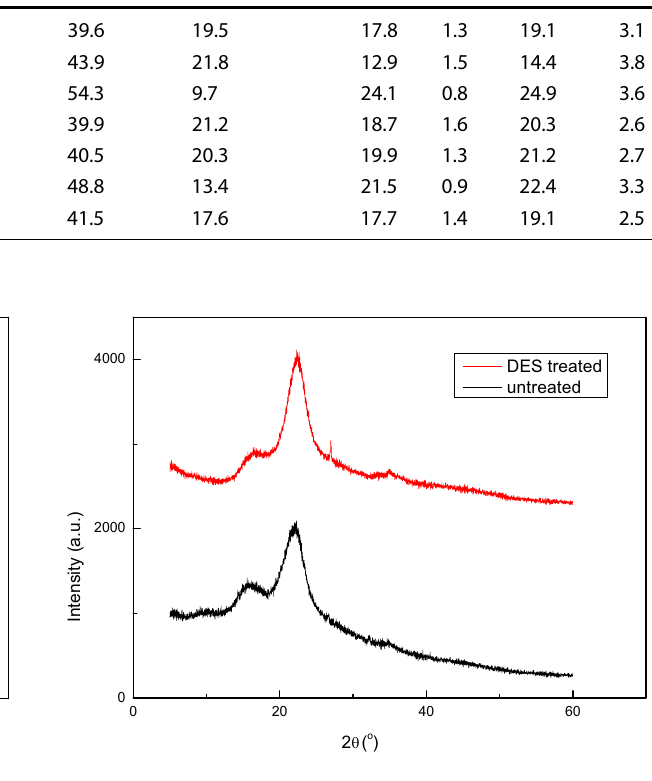
Table 2 Effect of different solvents pretreatment on the composition of corn stover